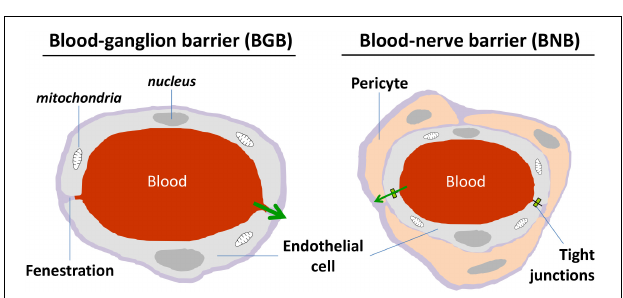
FIGURE 2 | Schematic representation of morphological characteristics of ganglion and nerve capillaries. Ganglion capillaries differ from nerve ones by the presence of fenestration and absence of narrow tight junctions. Nerve endothelial cells are surrounded by pericytes.